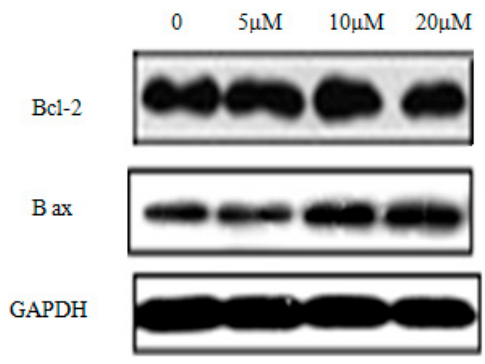
Figure 6. Expression of Bcl-2 and Bax in SK-N-SH cells after treatment by compound I-21 for 48 h.